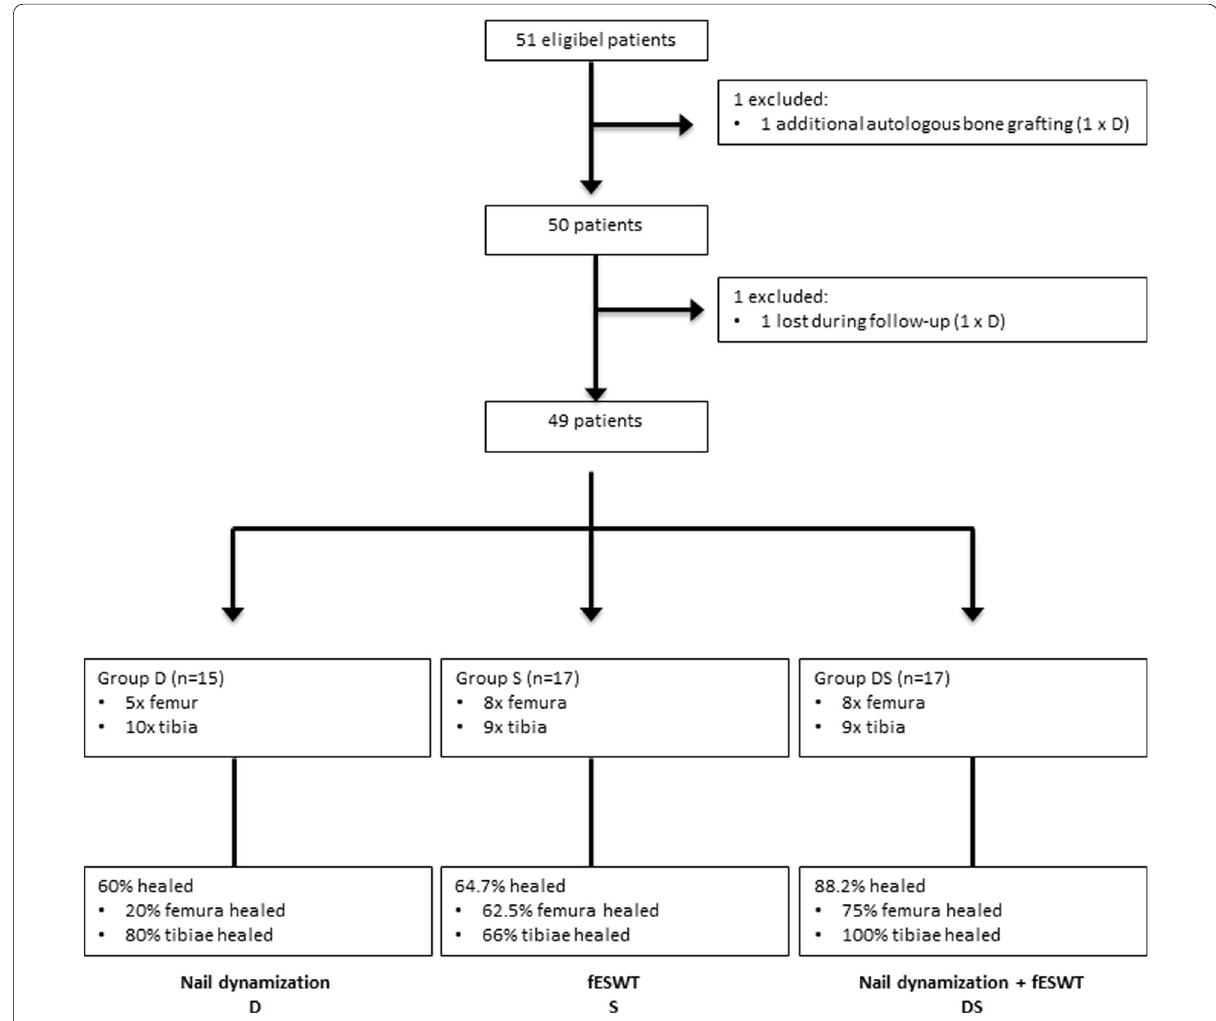
Fig. 1 Flow diagram of the study and treatment